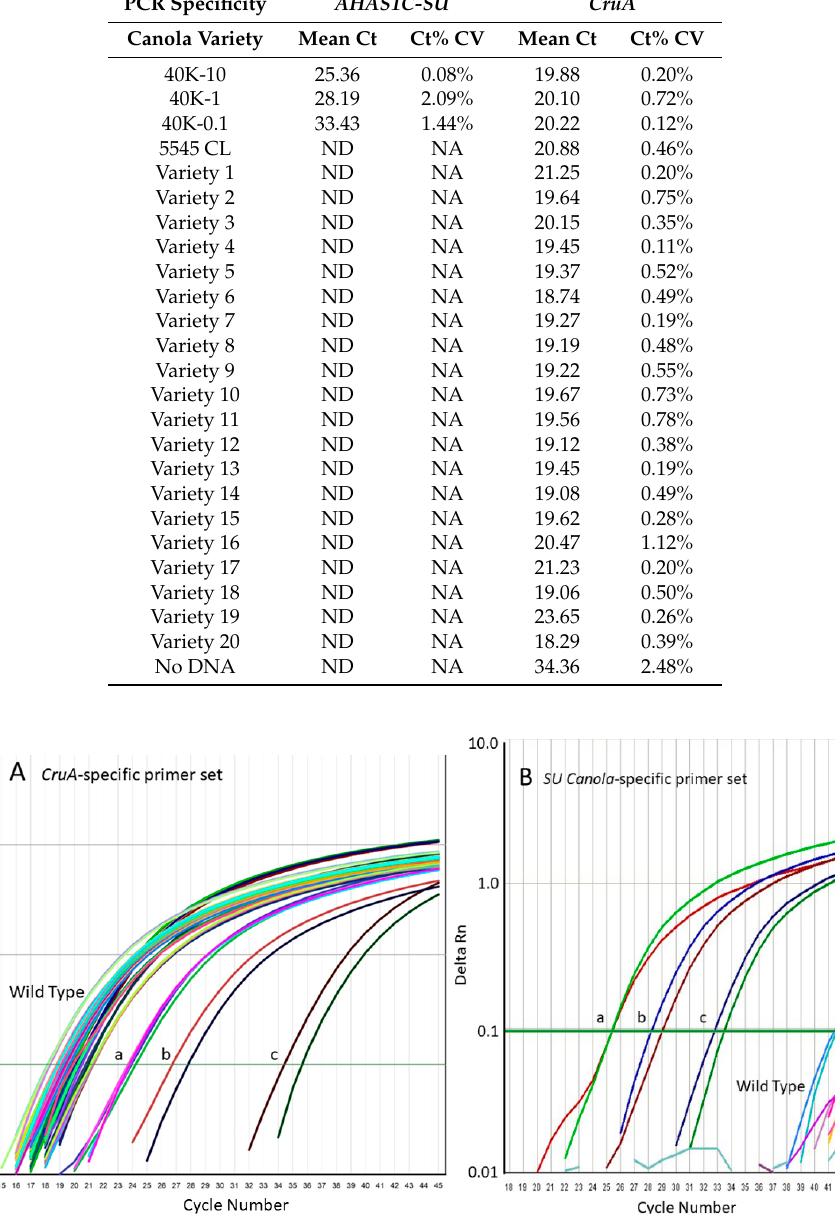
Figure 5. Quantitative PCR amplification curves for the results shown in Table 3. Panel A , Figure5. QuantitativePCRamplificationcurvesfortheresultsshowninTable3. Panel( A ),amplification amplification using the qPCR method specific for the canola endogenous reference gene ( CruA ); Panel usingtheqPCRmethodspecificforthecanolaendogenousreferencegene( CruA );Panel( B ),amplification B , amplification using the qPCR method specific for the AHAS1C-SU SNV of SU canola. Positive using the qPCR method specific for the AHAS1C-SU SNV of SU canola. Positive controls are DNA controls are DNA from SU canola event 40K at 300 (a), 30 (b), and 3 (c) ng 40K DNA per reaction. from SU canola event 40K at 300 (a), 30 (b), and 3 (c) ng 40K DNA per 3.3. Precision, Trueness, Limit of Quantitation and Limit of Detection of the SU Canola Method To determine the precision, trueness, limit of quantitation and limit of detection of the SU canola method, we combined decreasing proportions of DNA from SU canola event 40K with DNA from Clearfield canola variety 5545 CL. The units of relative concentration of SU canola DNA in 300 ng total DNA per reaction are weight SU canola DNA/weight total DNA (SU canola plus canola variety 5545 CL) percent. The results for proportions of SU canola DNA of 10%, 1.0%, 0.5%, 0.1%. 0.05% 0.01% and 0.0% are shown in Tables 4 and Figure 6. Total DNA was maintained constant at 300 ng/reaction, and reaction conditions were as described in Methods. Twelve replicate amplification reactions were carried out with each DNA mixture to assess the precision and trueness of amplification of the SU canola-specific PCR method. At 0.05% SU canola DNA, the relative standard deviation among replicates was ±16.8% and the percent trueness was ±6.93%. Both precision and trueness comply with ENGL acceptance criteria (relative standard deviation ≤ 25%, trueness ≤ ±25%) [40]. Based on these results, we conclude that the relative limit of quantitation for the SU canola PCR method is 0.05% for SU canola DNA in 300 ng total DNA. From this, we extrapolated the relative limit of detection to be 0.025% for SU canola DNA in 300 ng total DNA. See Supplementary Materials Table S5a,b for details of LOD and LOQ determinations. Table 4. Real-time quantitative PCR analysis of SU canola DNA, variety 40K, mixed at five concentrations with Clearfield canola variety 5545 CL. Total DNA was 300 ng/reaction and n = 12. PCR conditions, as described in Methods using the SU canola-specific primers and probe. % CV indicates % Coefficient of Variation. Declared SU Canola DNA Conc. Average Measured SU Canola DNA Conc.